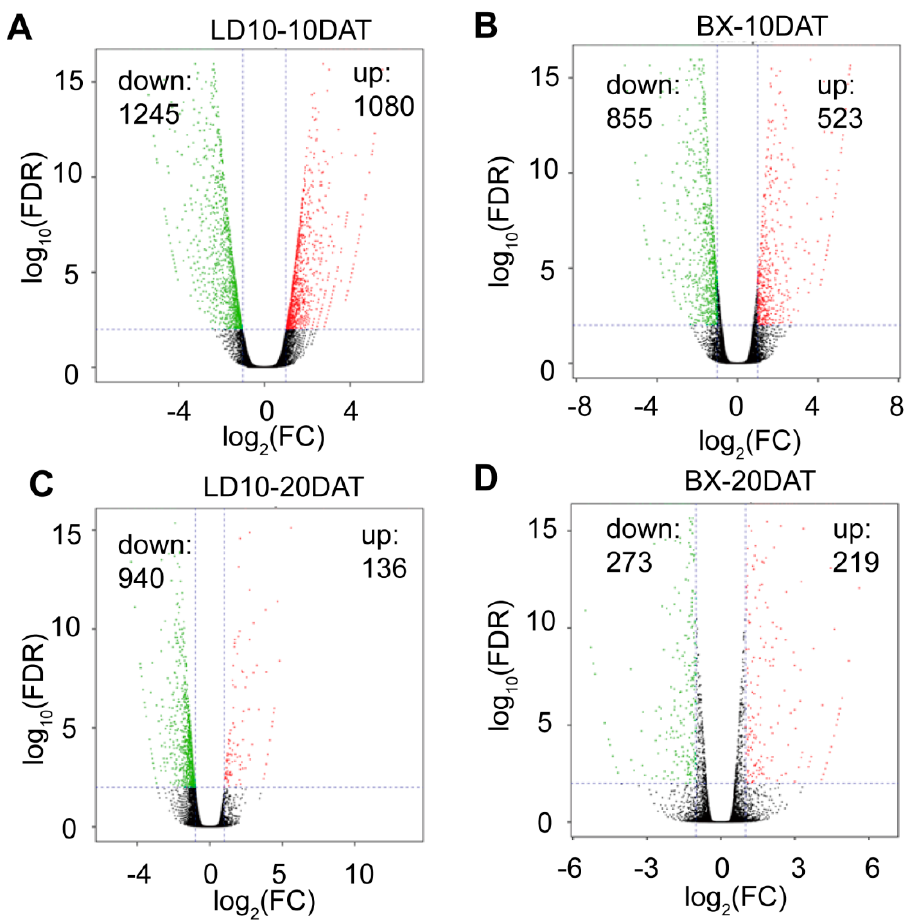
Figure 4. More differentially expressed genes were identified in LD10 than in BX induced by drought stress over two stages. ( A , B ) Differentially expressed genes (DEGs) for LD10 and BX at 10 days after drought treatment (10 DAT). ( C , D ) DEGs for LD10 and BX at 20 DAT. To decipher the reprogrammed biological pathways that are induced by DS, we per- formed both GO and KEGG analyses. Results show that some pathways of nuclease ac- tivity, RNA binding, Rubisco-bisphosphate carboxylase activity, and glutamate synthase (NADH) activity were significantly enriched in the upregulated DEGs in LD10 versus BX at 10 DAT (Figure 5A). For KEGG analysis, carbon fixation in photosynthetic organisms;